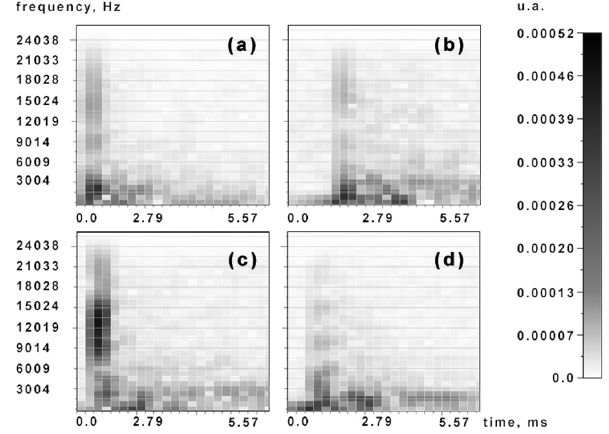
Figure 3. Spectrograms of the EM impulses resulting from impact action on (a) granite, (b) granodiorite, (c) quartz and (d) shale sam- ples.